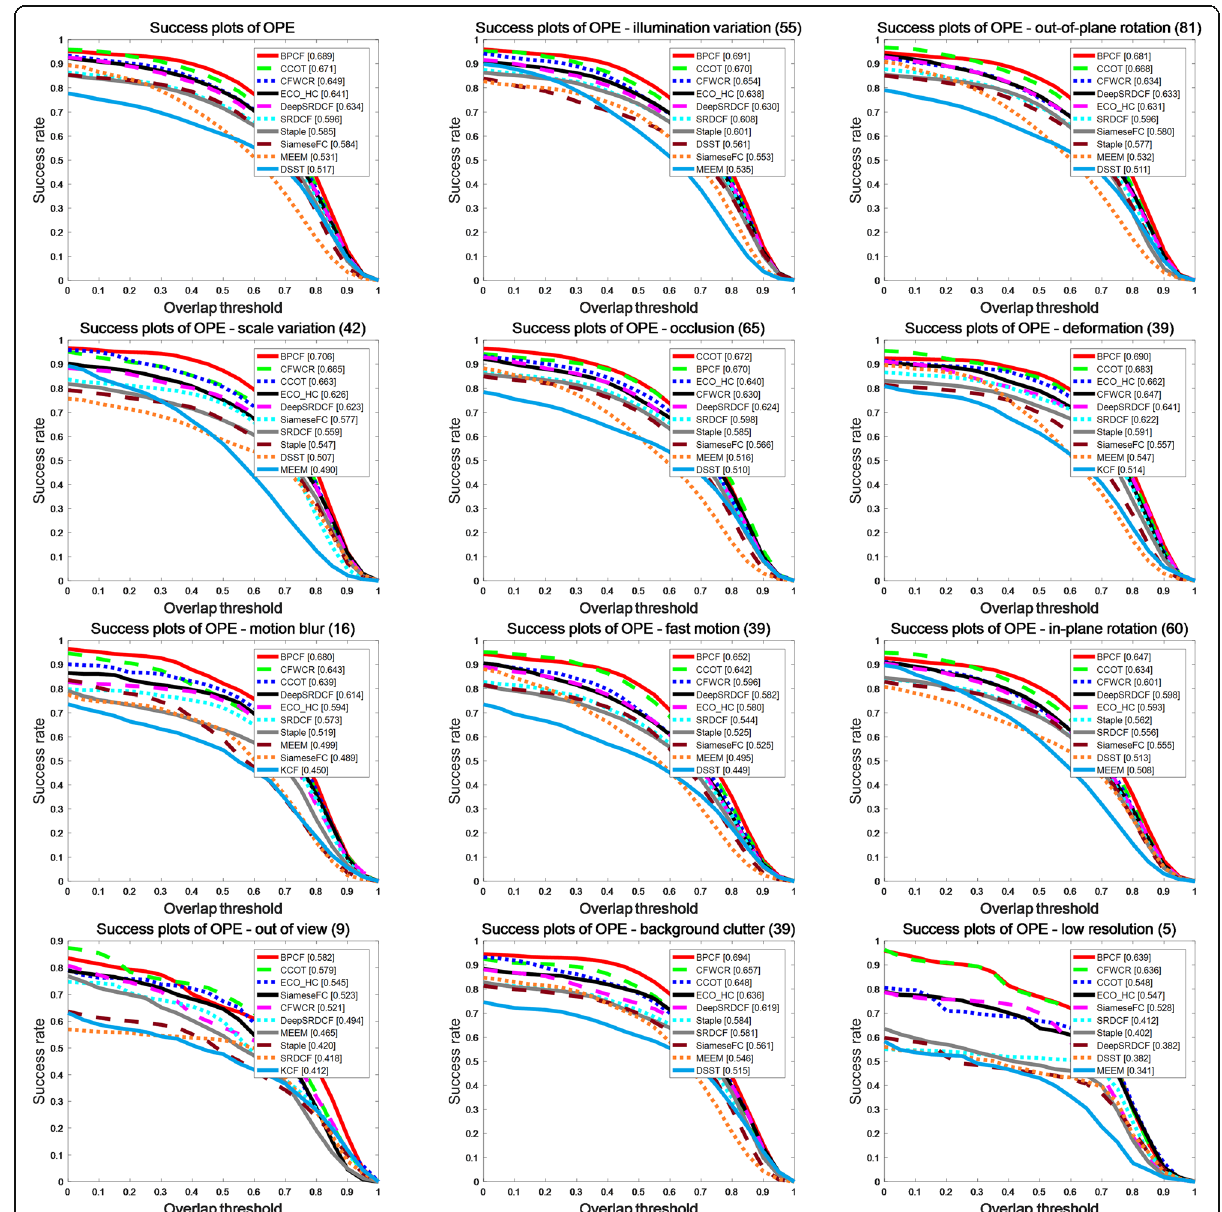
Fig. 5 State-of-the-art comparison. Success plot of OPE for some of the state-of-the-art trackers and BPCF on OTB-2015